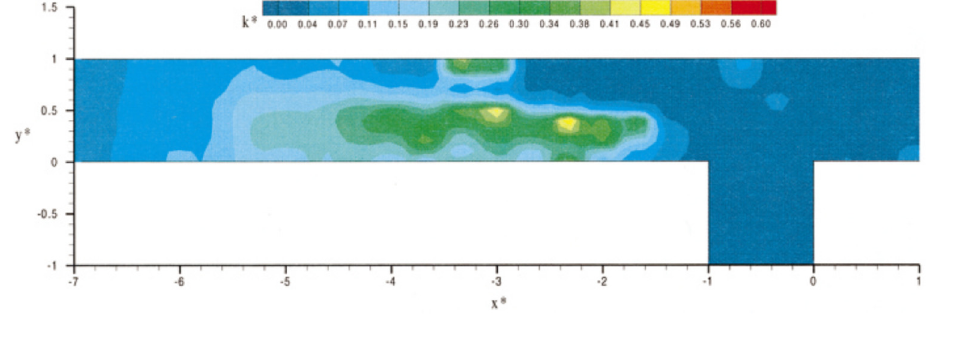
21 of 24 Figure 23. Comparison between experimental data and simulated results for longitudinal velocity contours. ( a ) Longitudinal Velocity Contours at Cross-Section x* = − 2.00 − experiment (Weber et al., 2001) [19]; ( b ) Longitudinal Velocity Contours at Cross-Section x* = − 2.00 − (Standard k- ε )- Simu- lated; ( c ) Longitudinal Velocity Contours at Cross-Section x* = − 2.00 − (Realizable k- ε )- Simulated. 3.4.5. Turbulent Kinetic Energy (k) The comparison between the experimental data of Weber et al. [19] and the simulated result for turbulent kinetic energy is shown in Figure 24. It could be seen from the figure that the area of high turbulence occurred along the boundary of the passing flow and the lower part of the separation zone. It is important to note that there was no significant